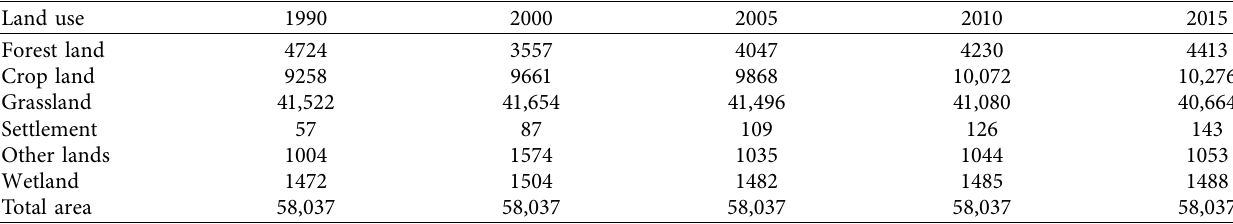
Table 1: Land use area in Kenya (1000ha),